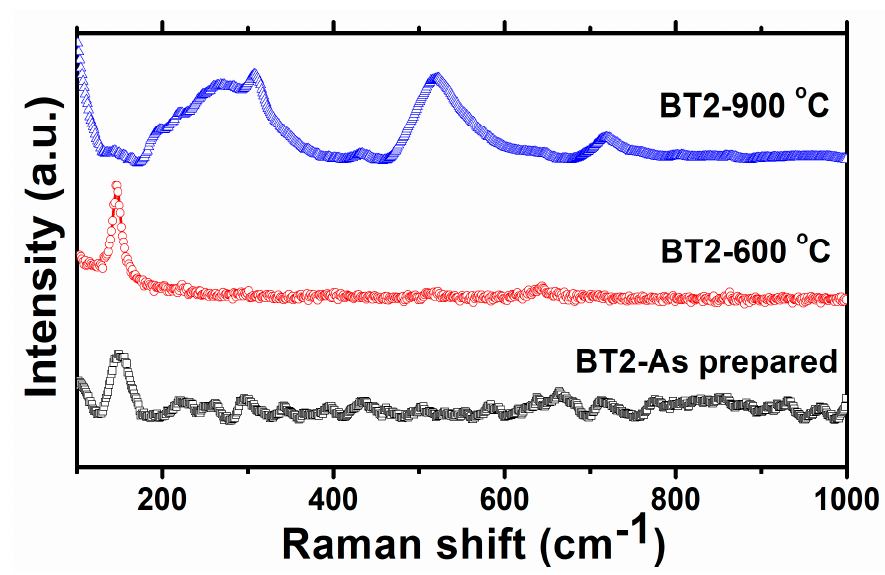
Figure 6. Raman spectra of BT2 sample calcined at different temperatures.